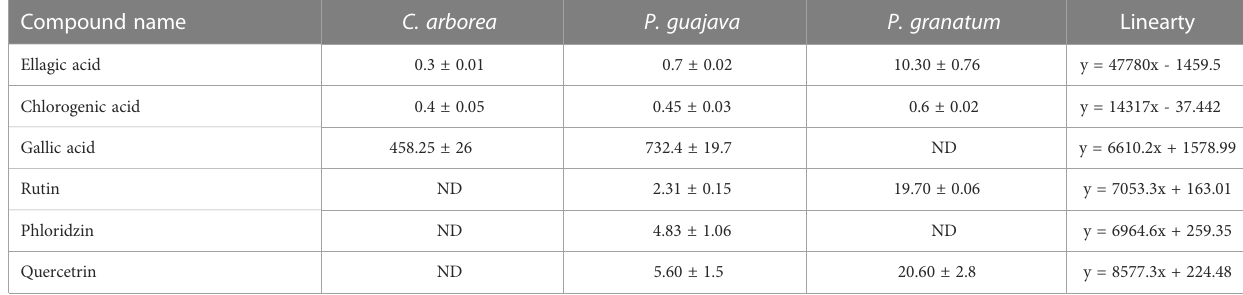
TABLE 3 HPTLC quantitative analysis of phenolics (EA, CHL and GA) and fl avonoids (RTN, PHD and QRTN) in ( m